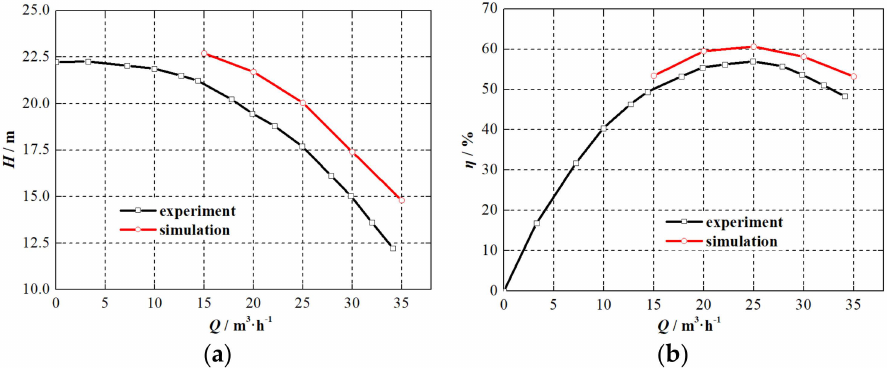
Figure 18. Scheme 16 pump performance. ( a ) H - Q curve. ( b ) η - Q curve.